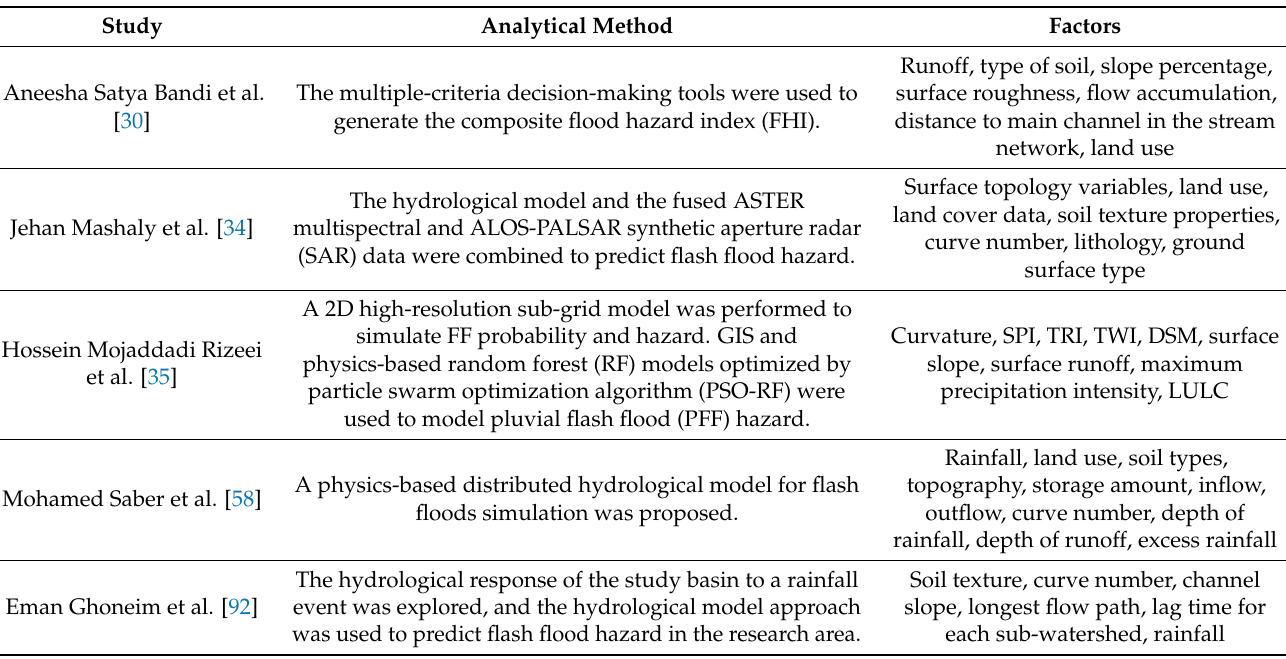
Table 4. For identification of flash flood hazard